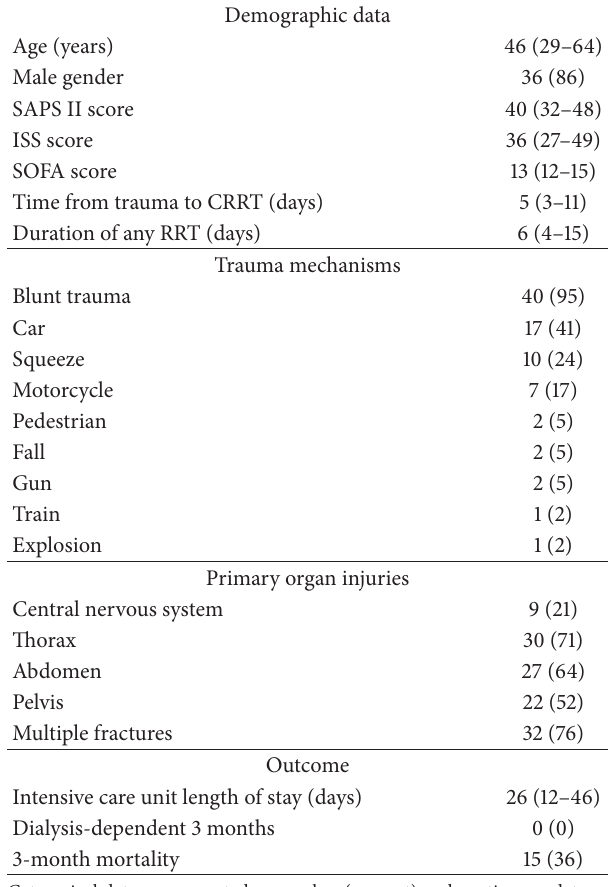
Table 2: Organ functions and performed procedures in trauma patients with acute kidney injury treated with continuous renal replacement therapy ( 𝑛 = 42